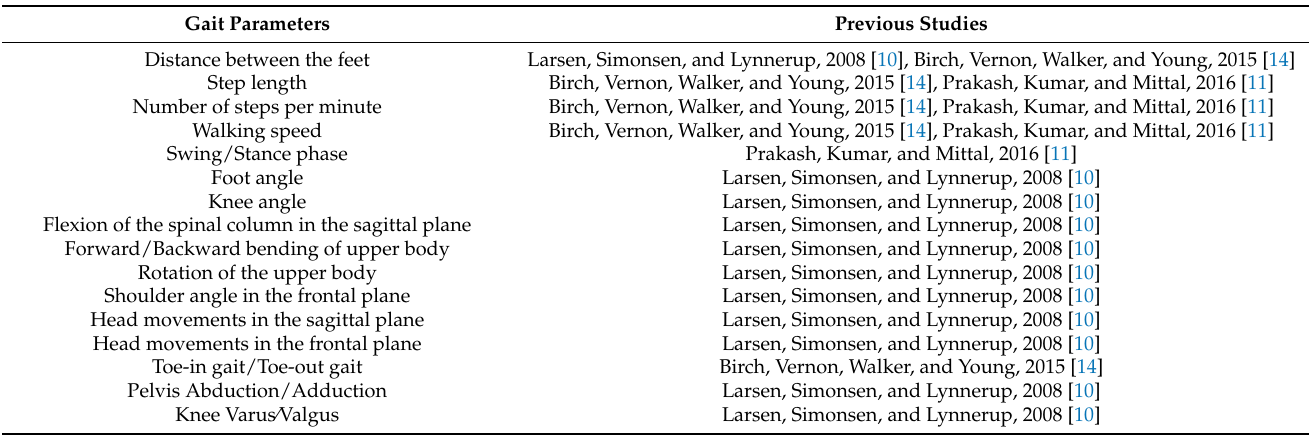
Table 1. Major gait parameters previously studied.